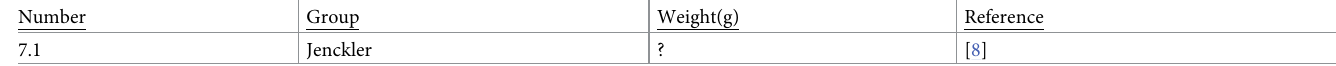
teenth century Vienna who serially duped antiquarian collectors. By this hypothesis, the coins